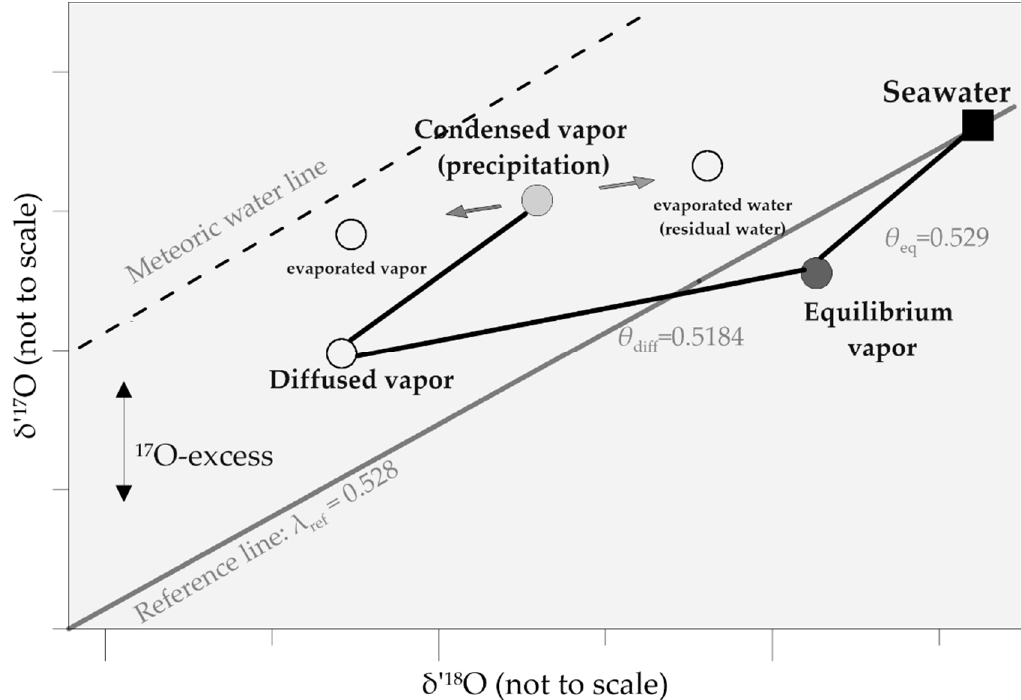
Figure 2. Schematic of δ ’ 17 O and δ ’ 18 O fractionation in the hydrological cycle. This figure is a simplified modification of the descriptions from Luz and Barkan [26] and Aron et al. [36].